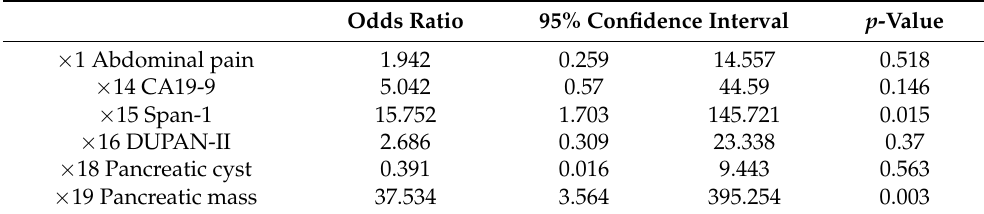
Table 3. Predictors of pancreatic cancer.